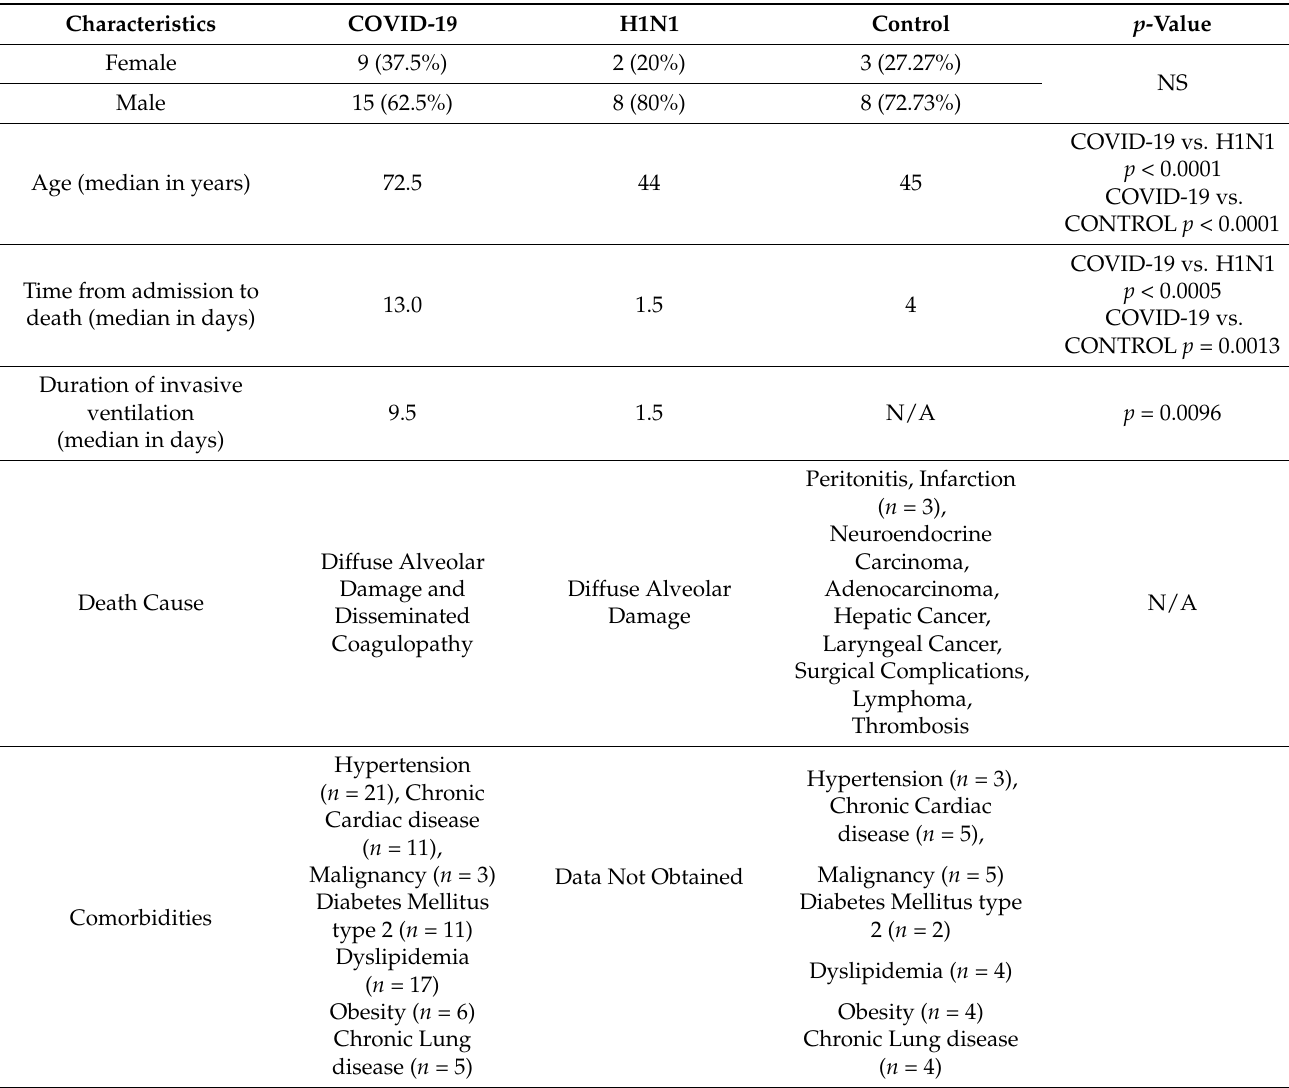
Table 1. Sample demographic